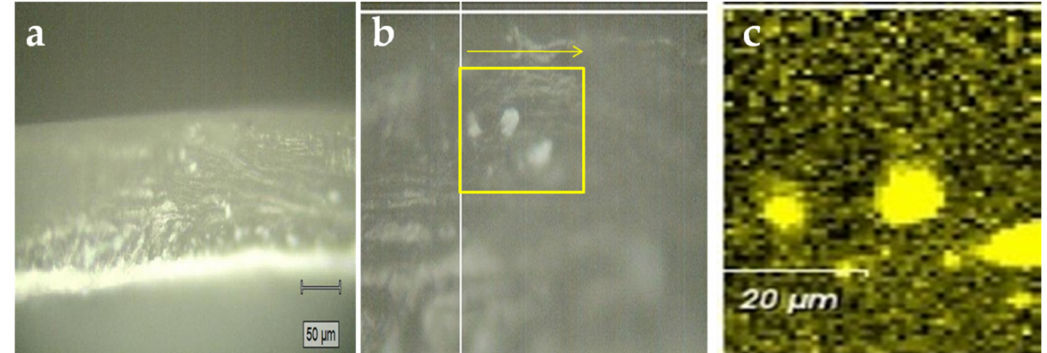
Figure 4. ( a ) Microscope images of a M5 membrane sample taken from side-view obtained during the Raman analysis; ( b ) area, within the yellow box, selected for mapping Raman analysis; ( c ) Nafion (black zone) and CTO (yellow zone) distribution in the selected